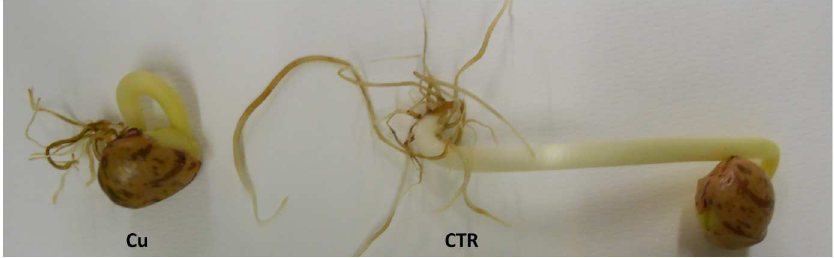
Fig 1. Growth of bean ( Phaseolus vulgaris L. var. soisson nain haˆtif) seedlings germinated in the presenceof distilled water or 200 μ M CuCl 2 .